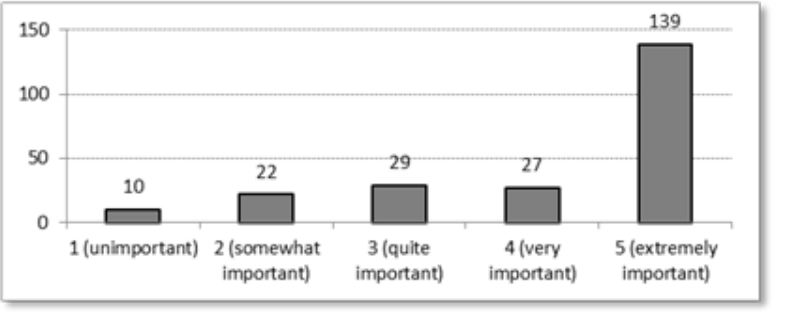
Figure 10. Importance given by deaf and hard of hearing e-learning students to cooperation with fellow learners (absolute numbers). Valid answers: 227.